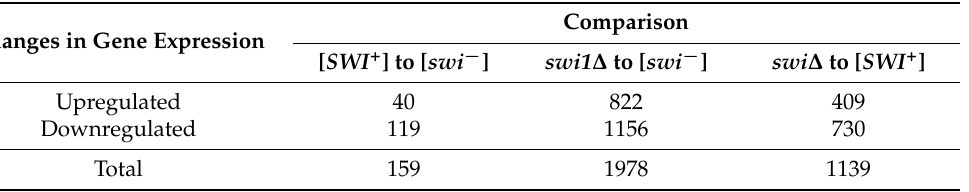
Table 1. Transcriptomic effects of the [ SWI + ] prion and SWI1 deletion on the media with galactose as the sole carbon source.